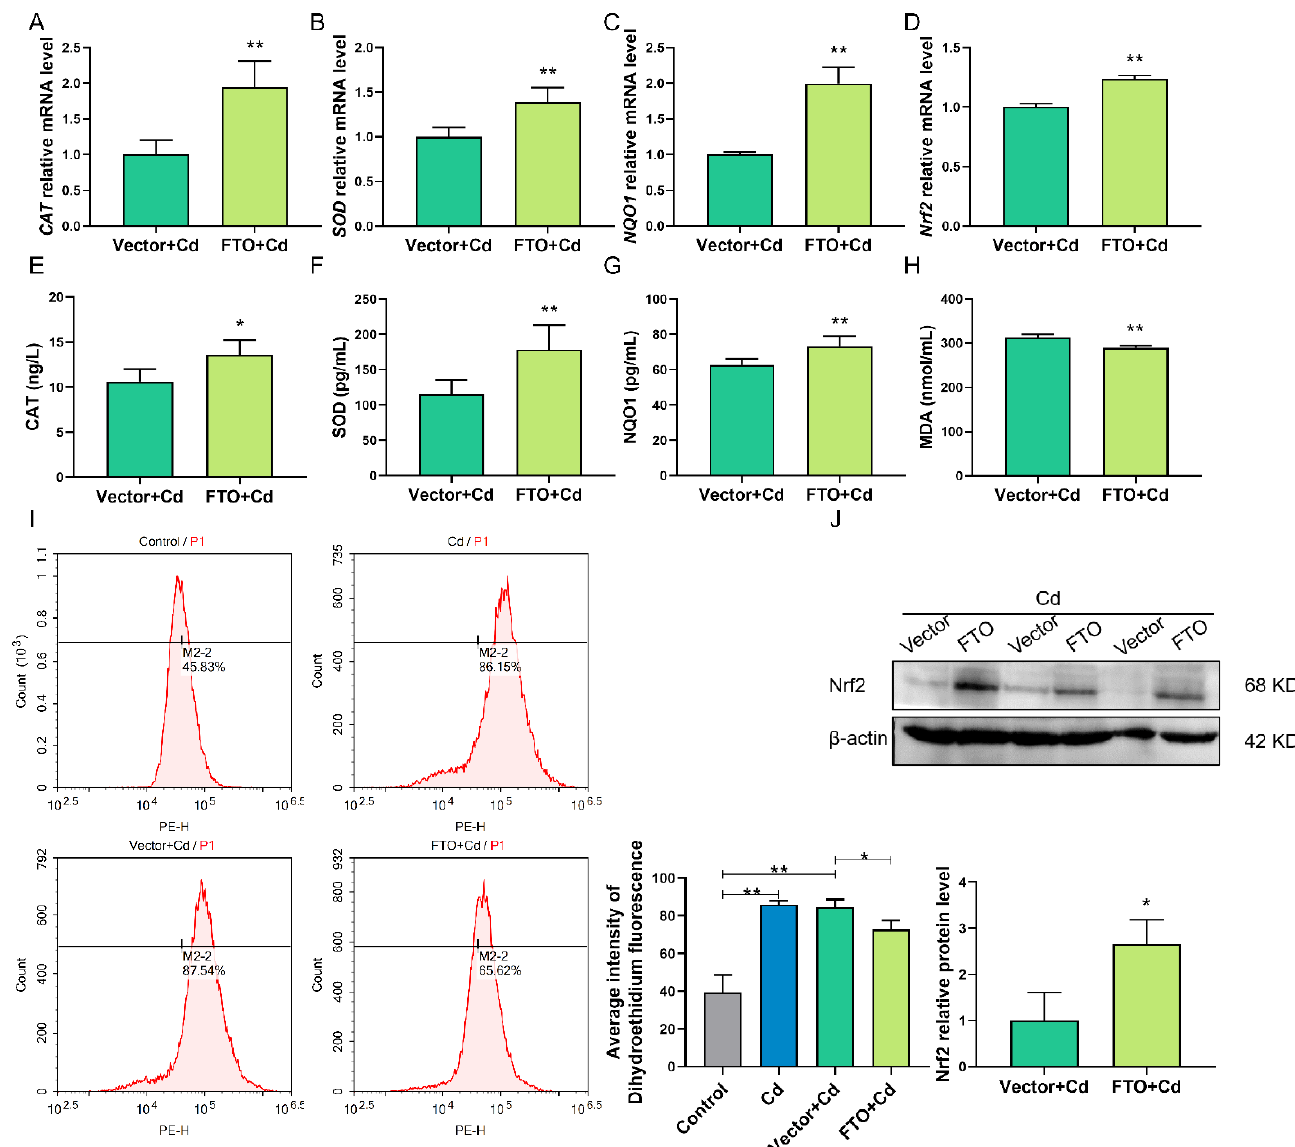
Figure 7. FTO overexpression suppressed Cd-induced oxidative stress. ( A – D ) RT-qPCR revealed the mRNA levels of CAT , SOD , NQO1 , and Nrf2 after Cd and FTO treatments. ( E – H ) ELISA results showed the intracellular levels of CAT, SOD, NQO1, and MDA after Cd and FTO treatments. ( I ) Intracellular ROS level was measured using flow cytometry analysis (DHE) in the control, Cd, Vector + Cd, and FTO + Cd groups. ( J ) Nrf2 protein levels were analyzed by Western blotting after Cd and FTO treatments. * p < 0.05; ** p < 0.01.